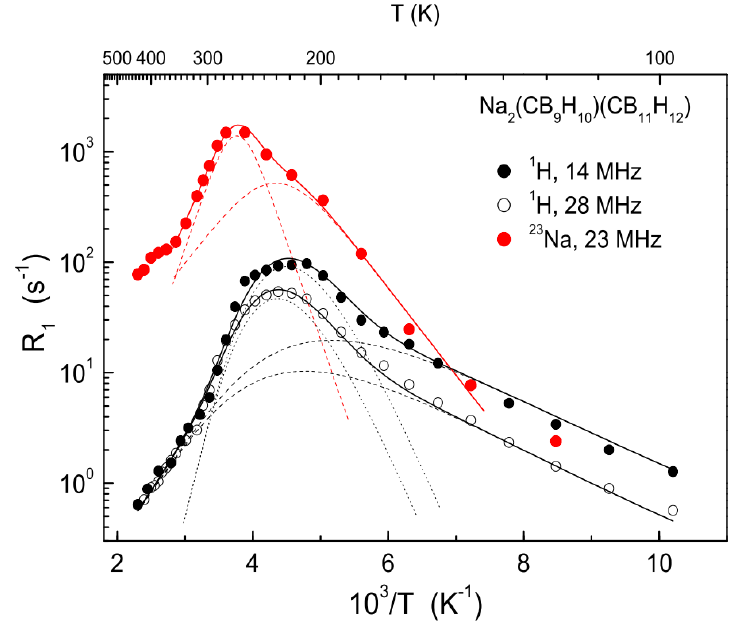
Figure 5. Proton spin–lattice relaxation rates measured at 14 and 28 MHz and 23 Na spin–lattice relaxation rates measured at 23 MHz as functions of the inverse temperature for the mixed-anion solid solution Na 2 (CB 9 H 10 ) (CB 11 H 12 ). The black solid lines show the simultaneous fit of the two-peak model with Gaussian distributions of the activation energies to the 1 H spin–lattice relaxation data in the range 98–435 K; the black dashed and dotted lines represent the contributions of the two components. The red solid line shows the fit of the two-peak model to the 23 Na spin–lattice relaxation data in the range 138–349 K; the red dashed lines represent the contributions of the two components. Reprinted with permission from reference [79]. Copyright 2019 Elsevier.